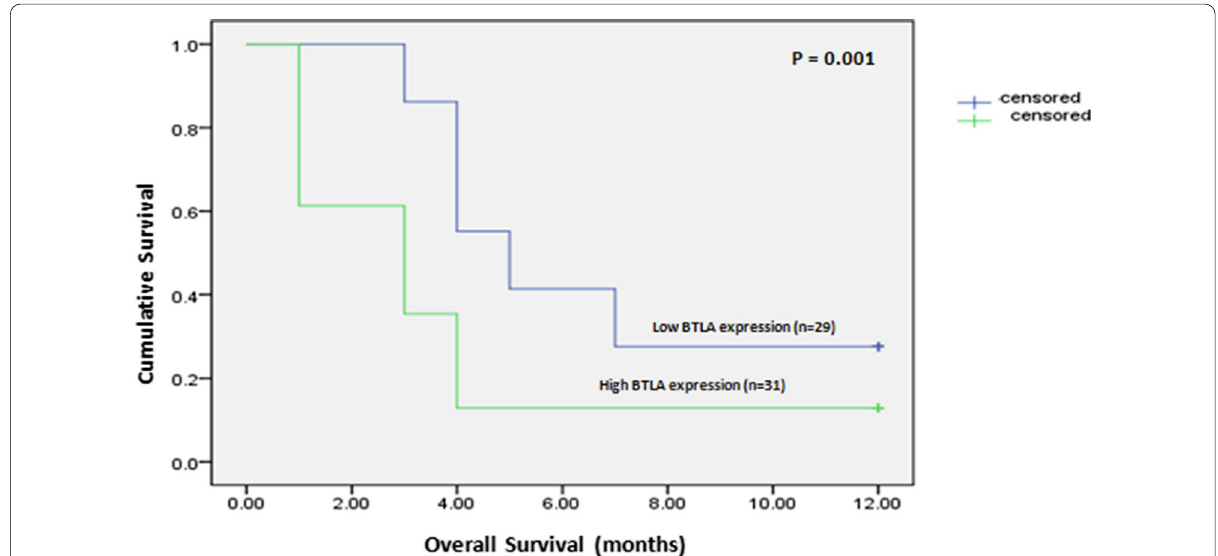
Fig. 5 Kaplan–Meier curves according to high or low BTLA fold